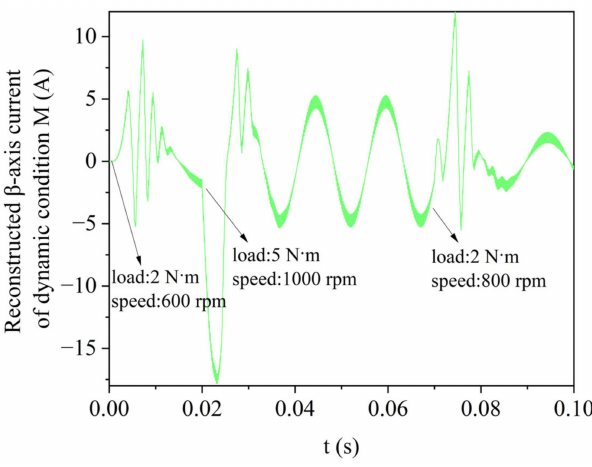
Figure 9. Reconstructed β -axis current of dynamic condition